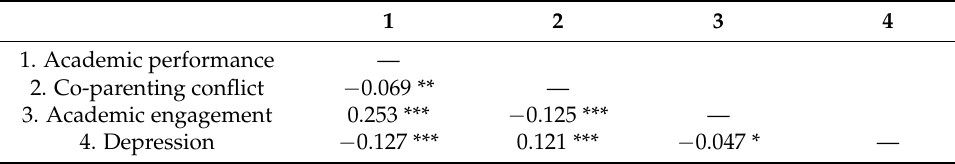
Table 2. Intercorrelations between all